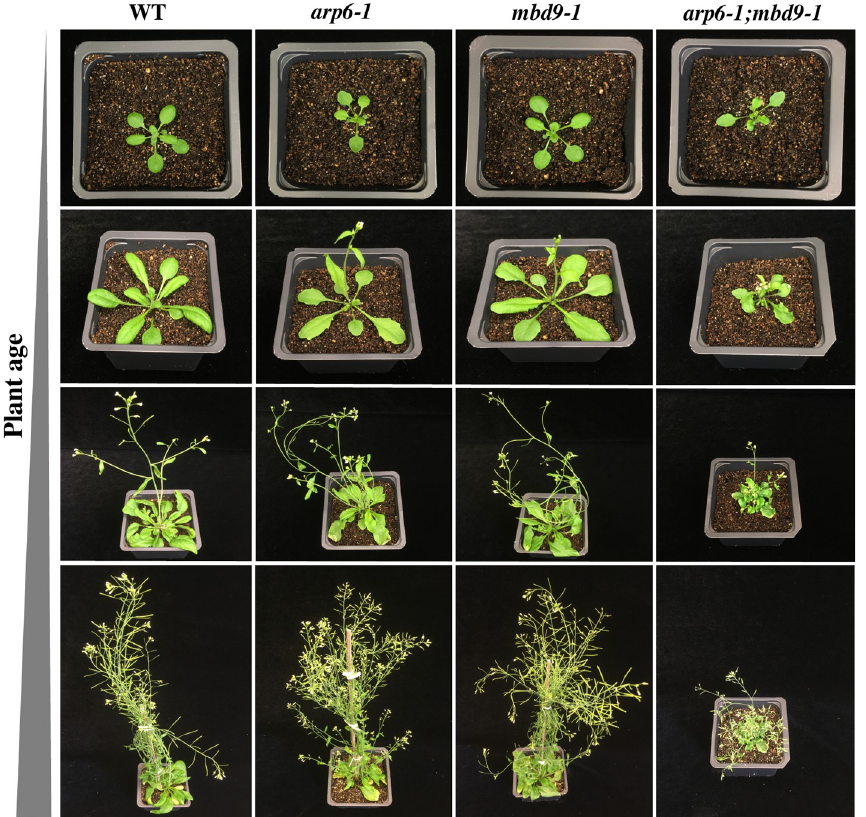
Fig 7. arp6-1;mbd9-1 double mutant plants have a more severe phenotype than either single mutant. WT, arp6-1 , mbd9-1 , and arp6-1;mbd9-1 plants grown under long-day conditions were individually photographed at 7, 14, 21, and 35 days after stratification. arp6-1;mbd9-1 double mutant plants have severely delayed development and are dwarfed compared to single arp6-1 and mbd9-1 mutant